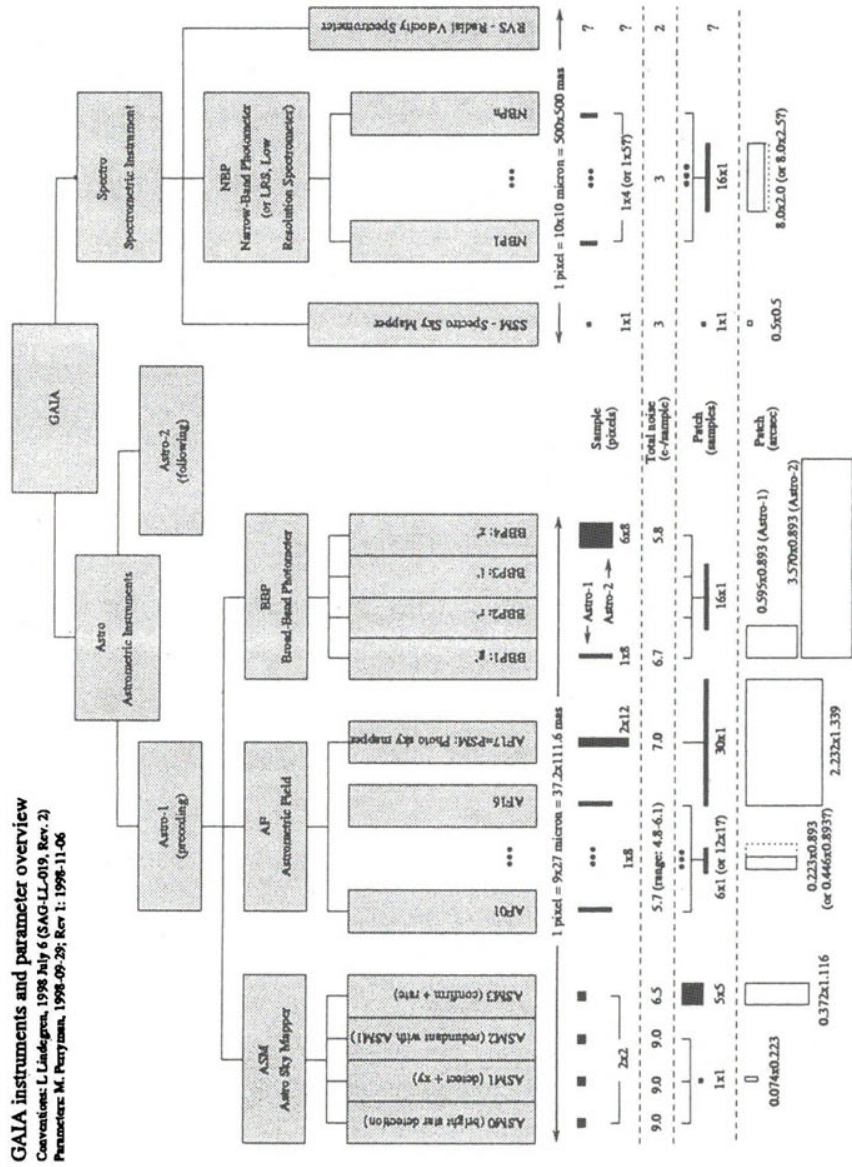
Fig. 7. Gaia instrument and parameter overview (by courtesy of L. Lindegren and M.